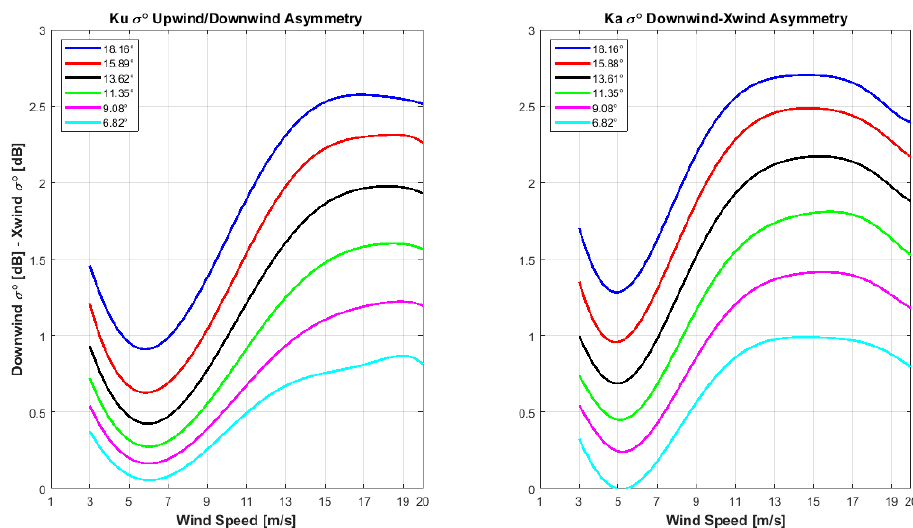
Figure 18. Peak-to-peak KuPR( left ) and KaPR ( right ) downwind/crosswind σ 0 anisotropy (in dB) as a function of WS at different EIAs.